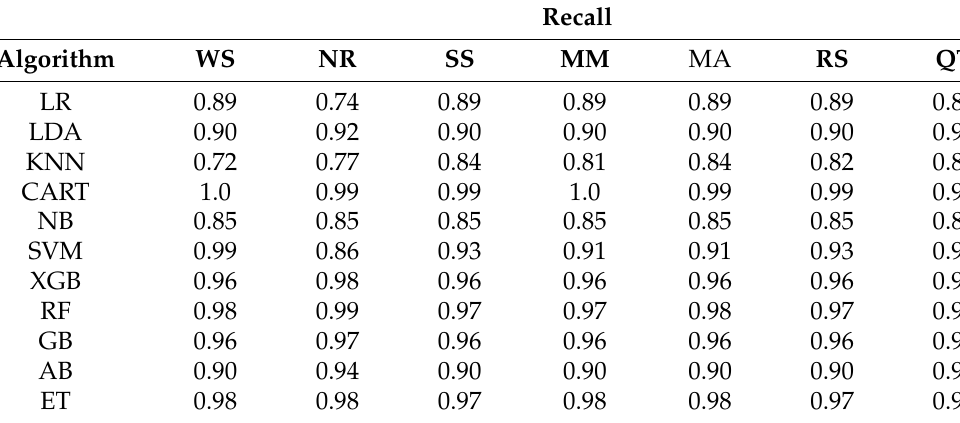
Table 7. Overall performance of different algorithms based on